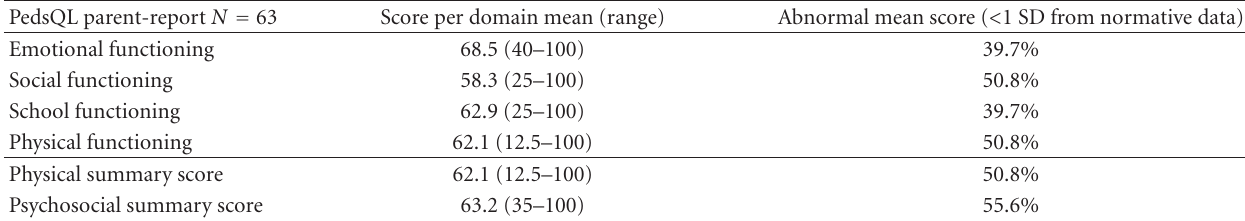
Table 2: Performance on PedsQL domains.